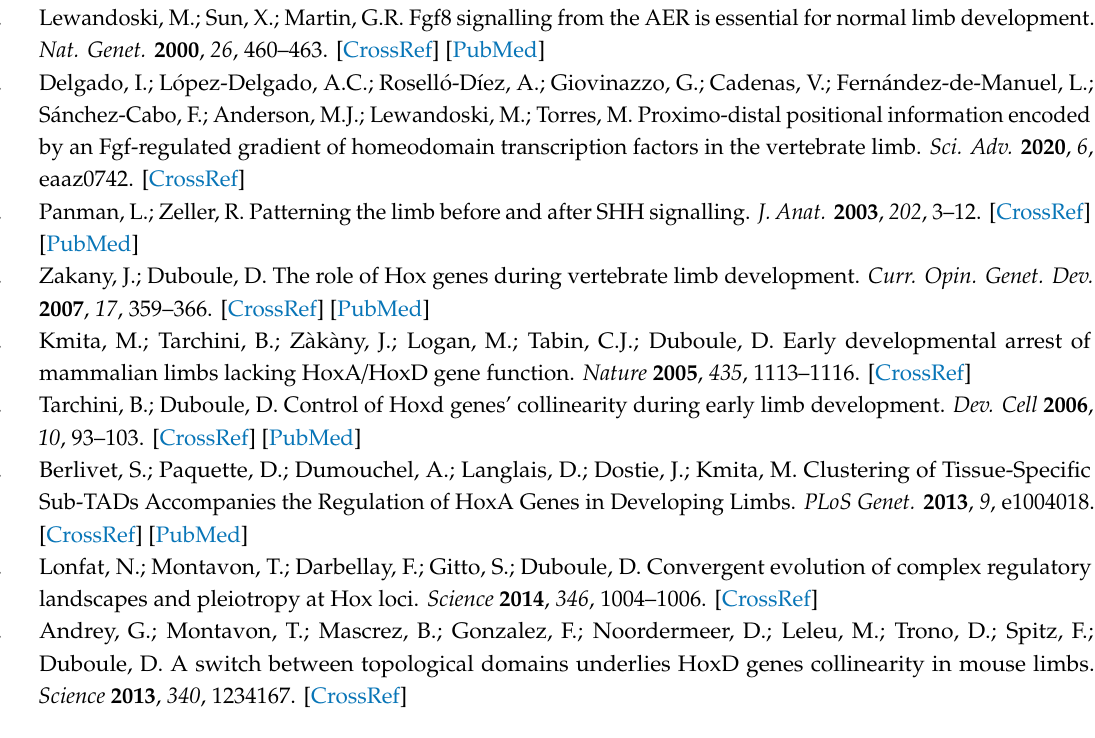
Figure S1: Expression profiles of the di ff erent gene markers in the developing mouse limb bud, Figure S2: Prevalence of the distal limb tissue as compared to proximal tissue, Figure S3: Examples of dynamic expression of distal genes during limb bud development, Figure S4: Annotation of the clusters identified by scATAC-seq and Figure S5: Analysis of the Hox13 − ;Gfp + cell population in the developing limb